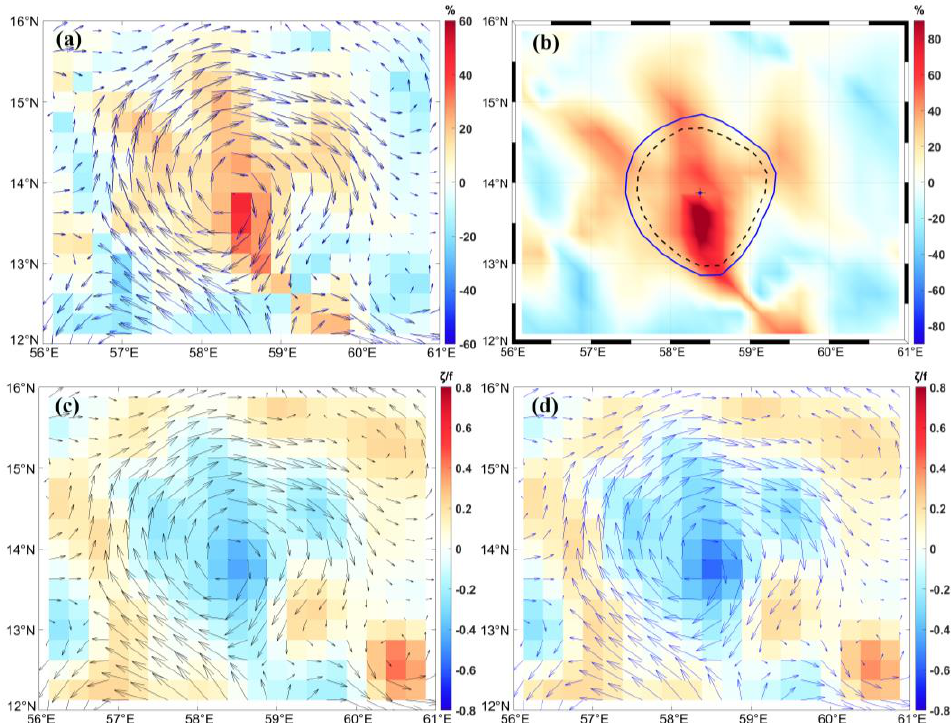
Figure 5. Cyclogeostrophic correction of an anticyclonic eddy in the northern hemisphere on 29 July 2011. ( a ) Spatial comparison of corrected velocity and initial geostrophic velocity. The black vectors represent the initial geostrophic current, the blue vectors represent the cyclogeostrophic current. ( b ) The black dotted circle and dot represent the anticyclonic eddy boundary and center derived from the altimeter, and the blue solid circle and plus sign represent the anticyclonic eddy boundary and center following the cyclogeostrophic correction, while the background color represents the relative difference of the eddy kinetic energy. ( c ) The black vector arrow represents the initial geostrophic current, and the background color represents the normalized relative vorticity ( Ro ) of the initial geostrophic current. ( d ) The blue vectors represent the cyclogeostrophic current, and the background color represents the normalized relative vorticity ( Ro ) of the cyclogeostrophic current.